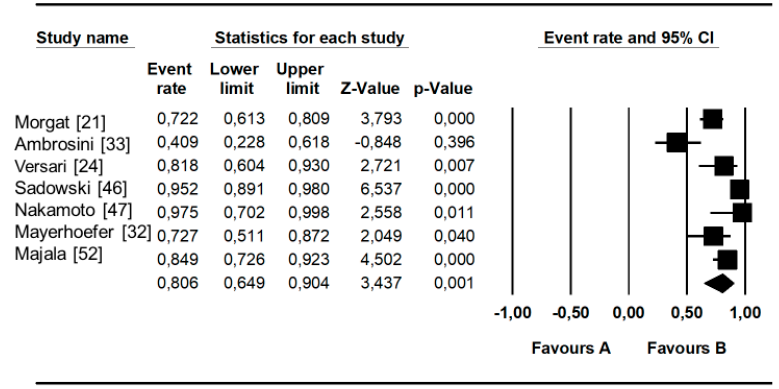
Figure 4. Detection rate at a per-patient analysis. Plots of individual studies and pooled detection rate of SSR-PET/CT in patients with pNET on a per-patient-based analysis, including 95%CI.